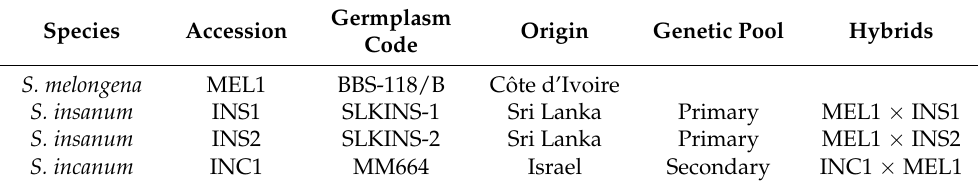
Table 4. Information on the Solanum species analysed in this